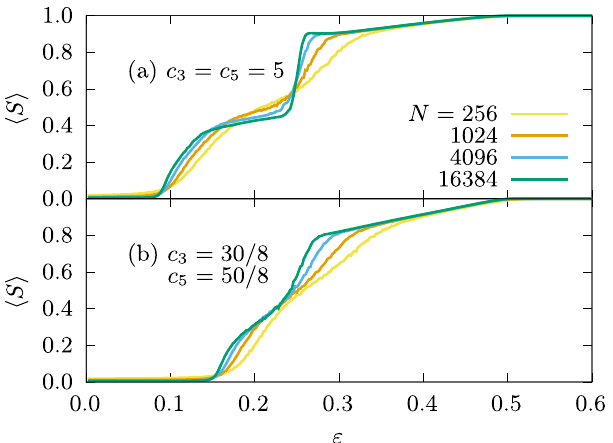
Fig. 7 Behaviour of the mean relative size of the largest cluster for heterogeneous Erd ő s – Rényi hypergraph. Mean relative size of the largest cluster h S i as a function of the con fi dence ε for the HOID model on heterogeneous hyper-ER graphs with connectivity of c = 10 = c 3 + c 5 , where the connectivity c 3 is caused by k = 3 hyperedges and c 5 by k = 5 hyperedges. In case ( a ) both types of hyperedges cause the same connectivity c 3 = c 5 = 5. In case ( b ) there are on average equal numbers of both hyperedges, i.e., c 3 = 30/8 and c 5 =